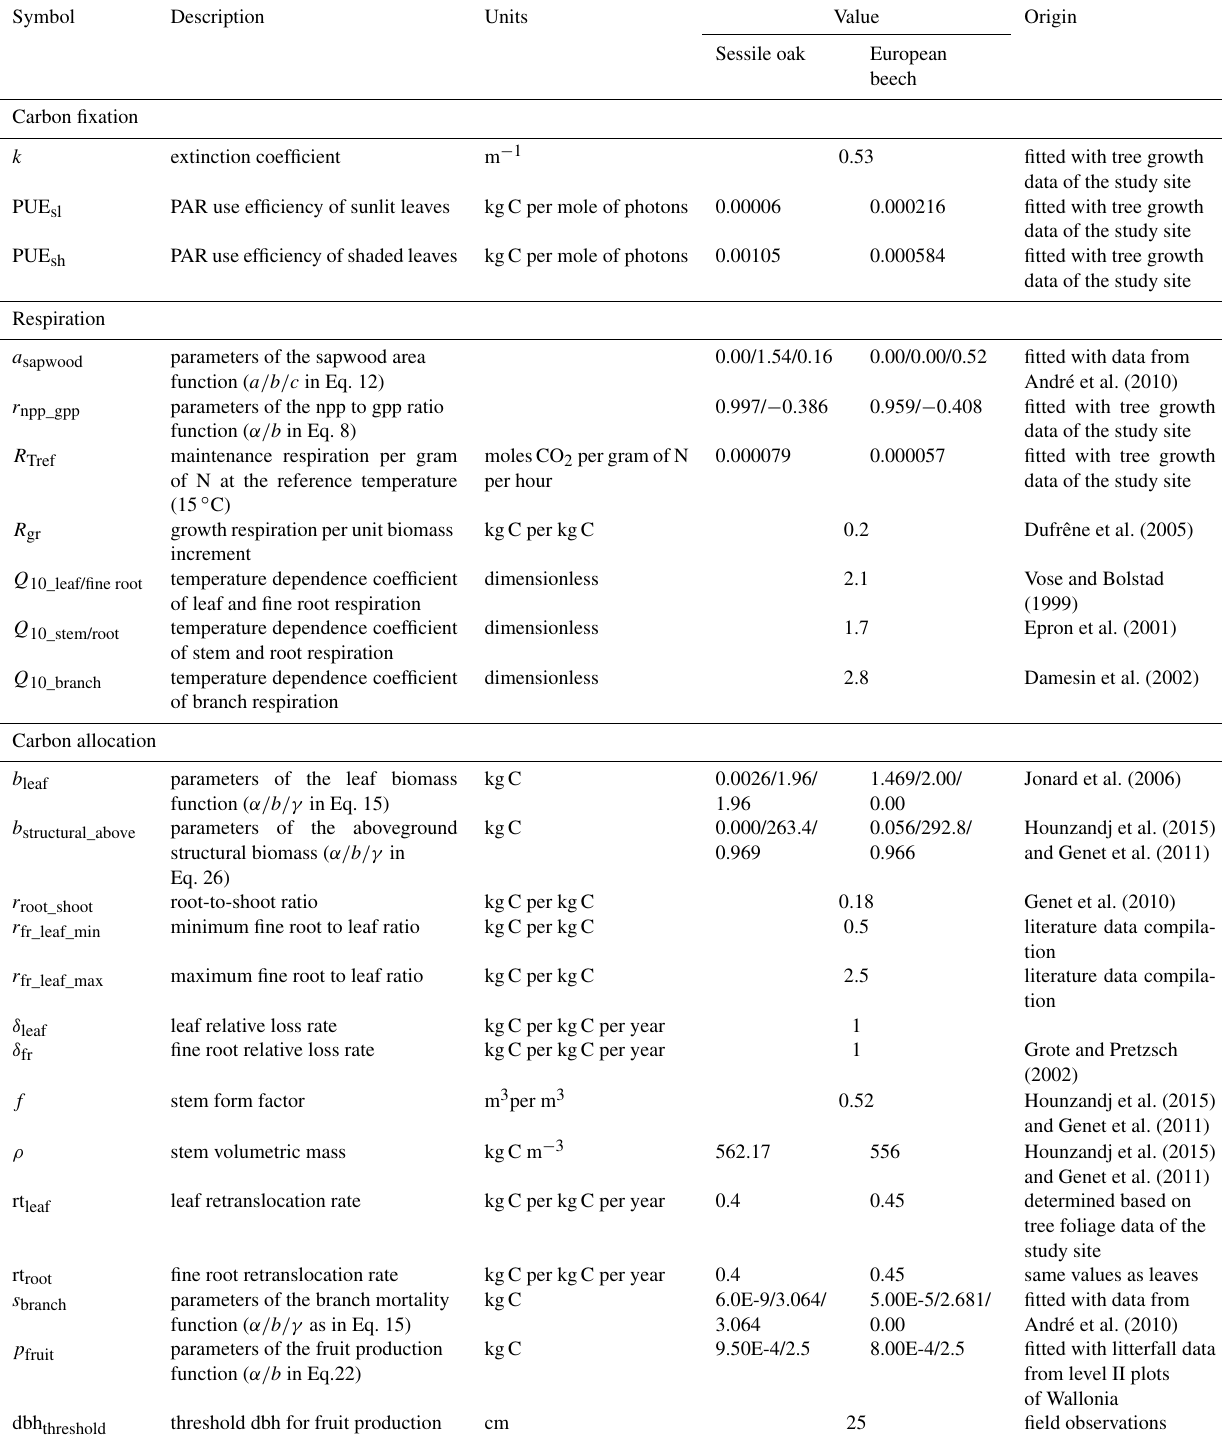
Table 2. Description of model parameters for sessile oak and European beech and origin of their value.